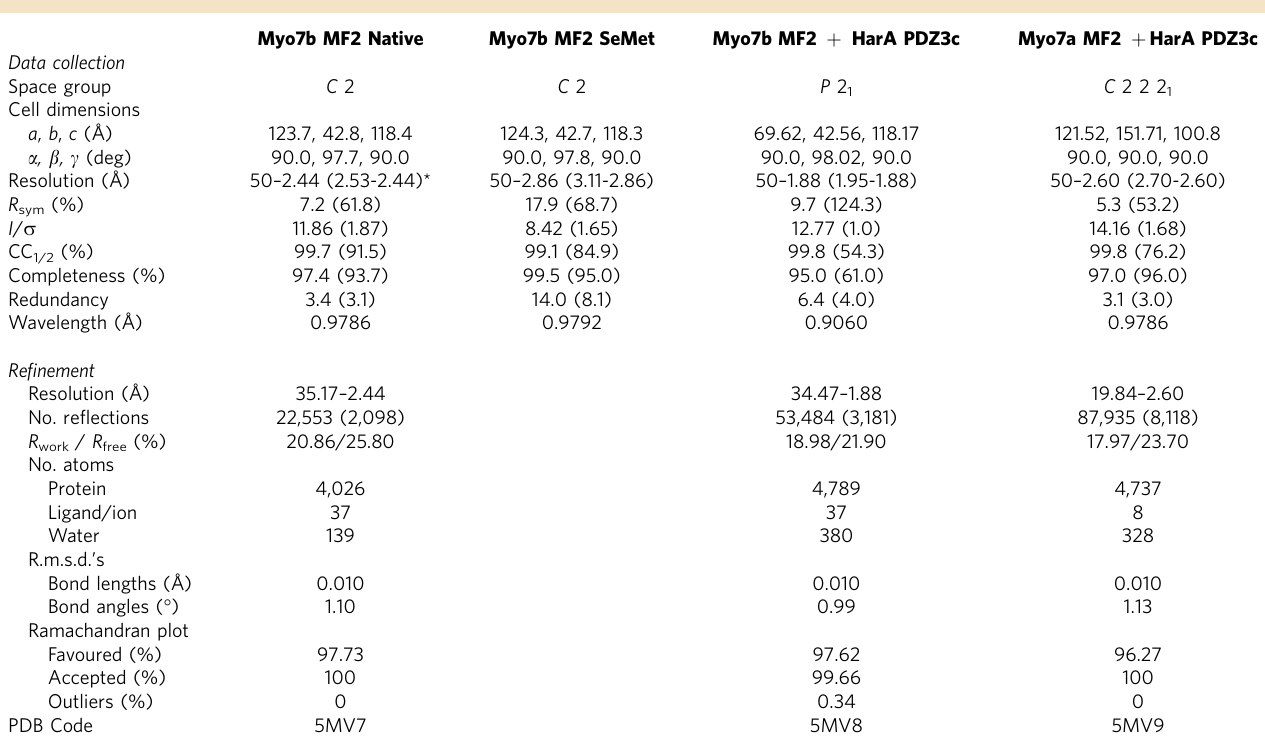
Table 2 | Data collection and refinement